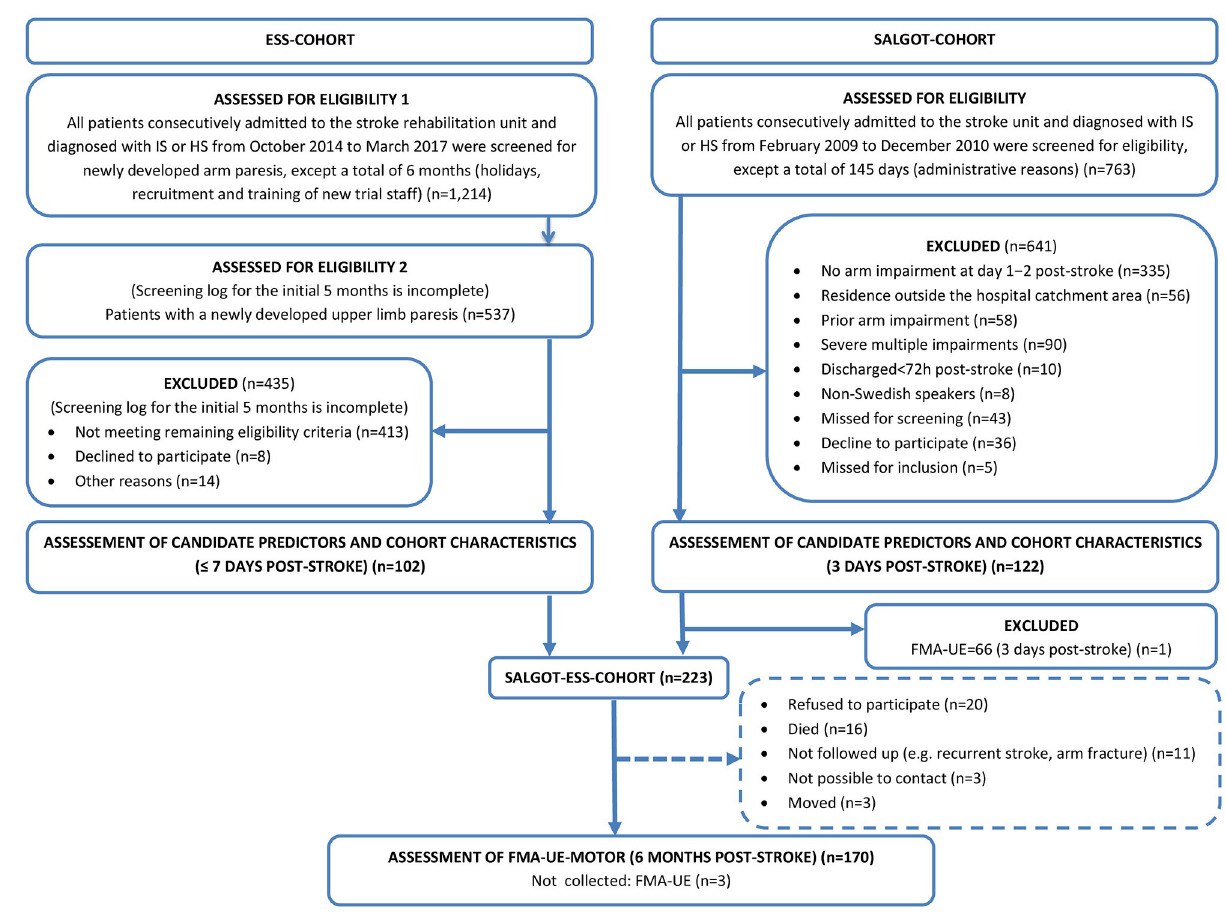
FIGURE 1 | Flowchart of the inclusion process. ESS, the Electrical Somatosensory Stimulation trial; SALGOT, the Stroke Arm Longitudinal Study at the University of Gothenburg; FMA-UE, the motor section of the Fugl-Meyer Assessment of Upper Extremity (0–66